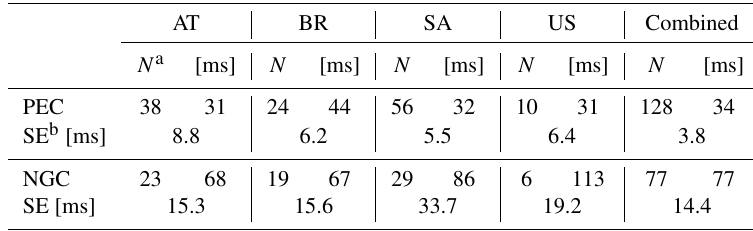
a N is sample size. b SE is standard